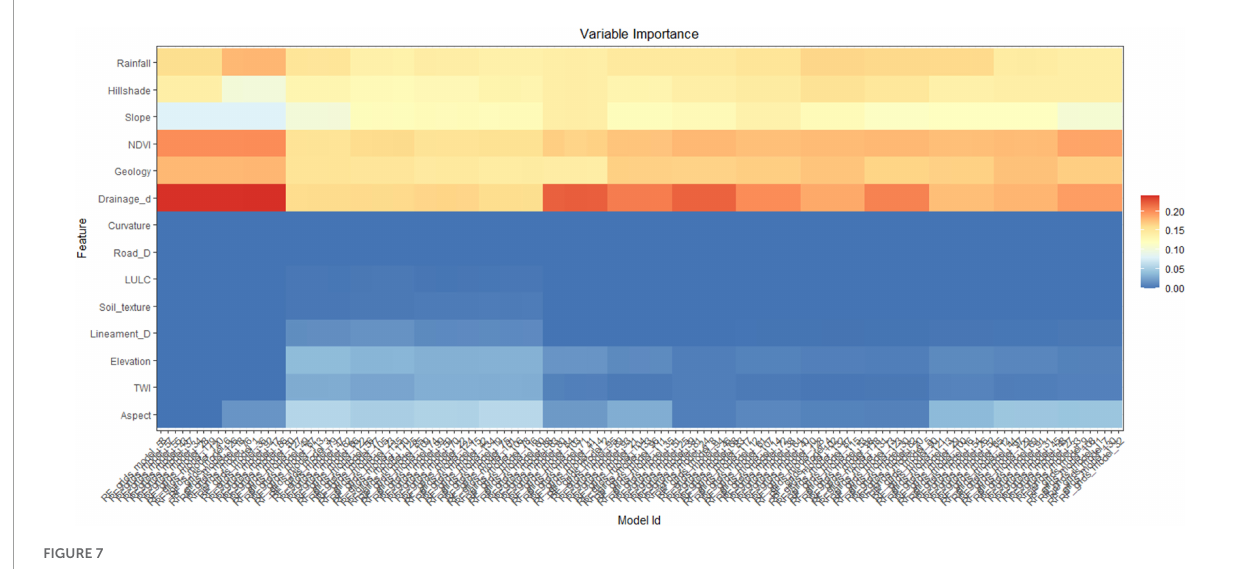
FIGURE7 Computation of important variables for predicting LSM as per the top 132 RF models.